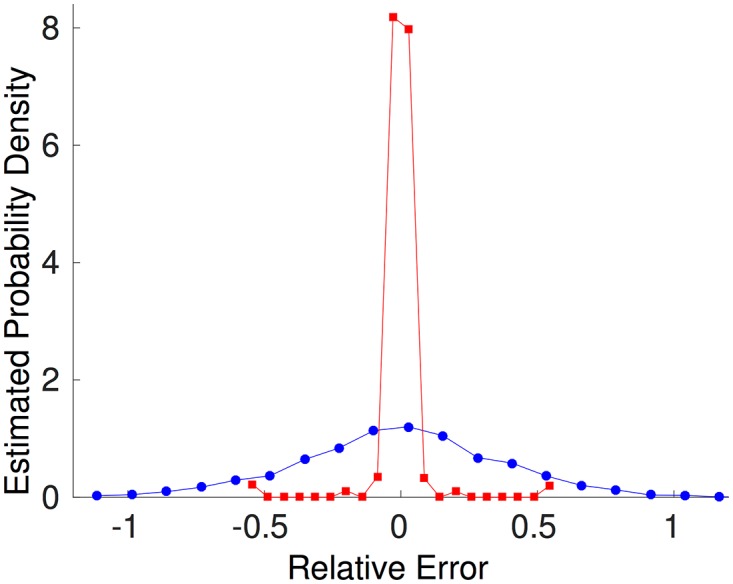
Error comparison for cluster-aided and ‘full’ inference.A posteriori probabilities of inference errors for the cases of the reduced model (red curve) and the full matrix inference (blue curve). Details in the text.